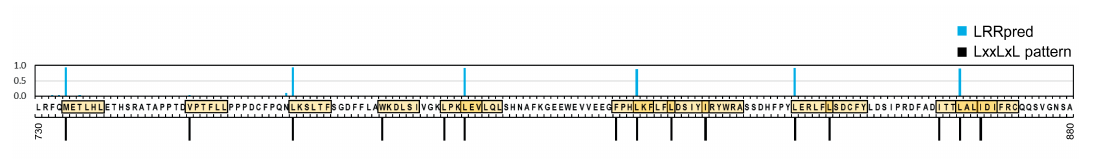
Figure 8. LRR motif and repeat indeterminacies onto a 150 aa stretch in Gpa2 potato NLR. Potential motifs that follow the minimal ‘LxxLxL’ pattern (where L is any hydrophobic amino acid) are illustrated above the sequence with black bars and yellow highlight, while LRRpredictor results are shown above with blue bars.